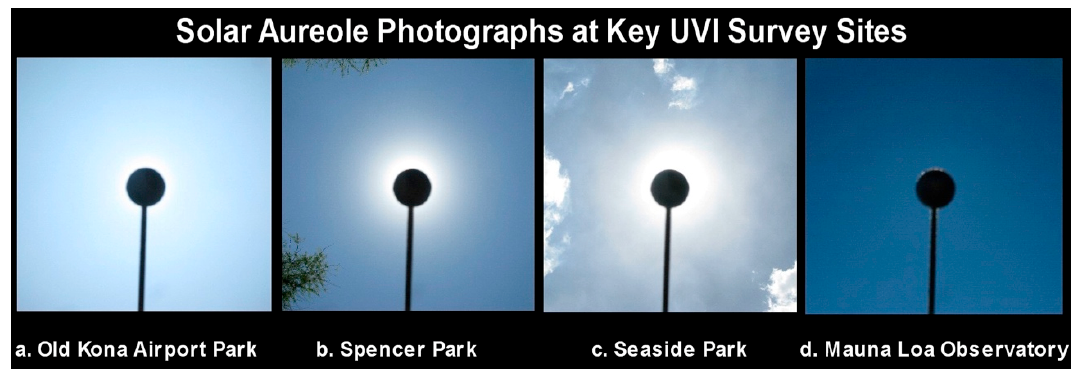
Figure 14. Solar aureole photographs made by blocking the sun with a black ball mounted on a digital camera [48]. The pale sky in ( a – c ) is caused by vog.